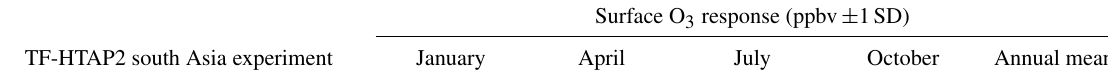
Table 6. Monthly and annual mean surface O 3 changes (ppbv) over south Asia due to a 20% reduction in anthropogenic precursor emissions over this region. Multi-model mean values are shown with ± 1SD for the available TF-HTAP2 models and the parameterised approach based on multiple